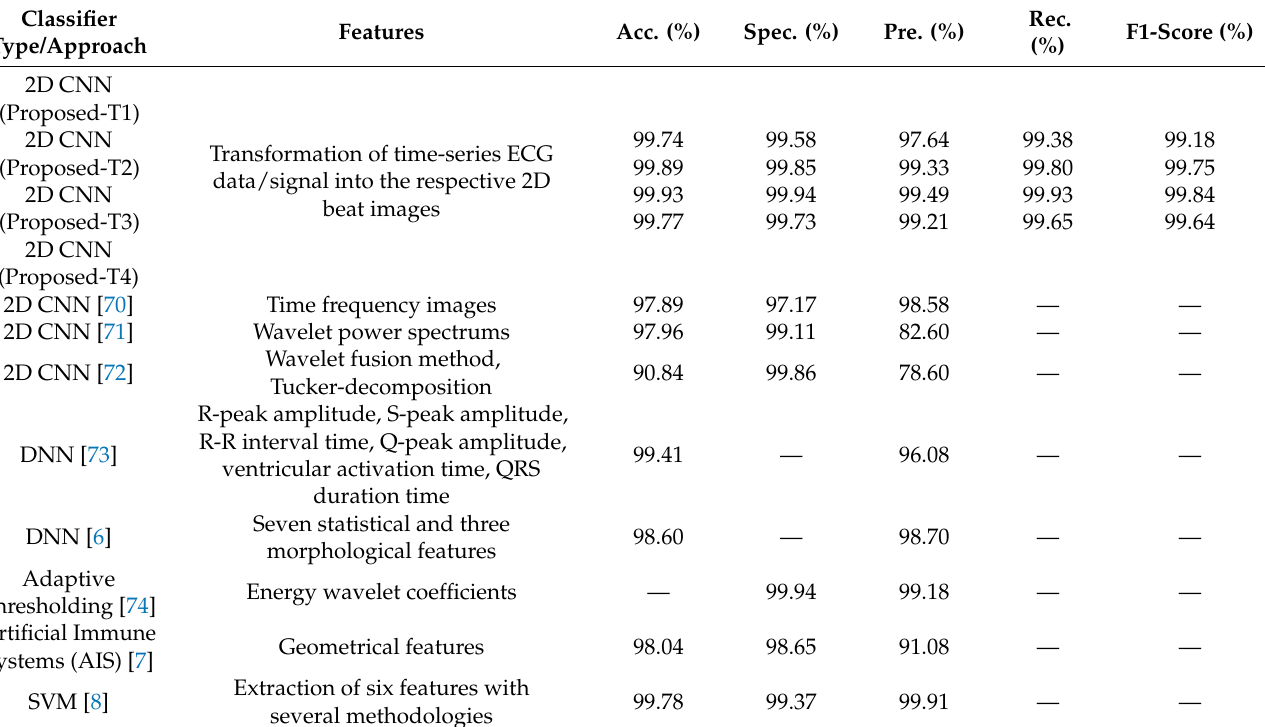
Table 5. Various recent methods for identifying